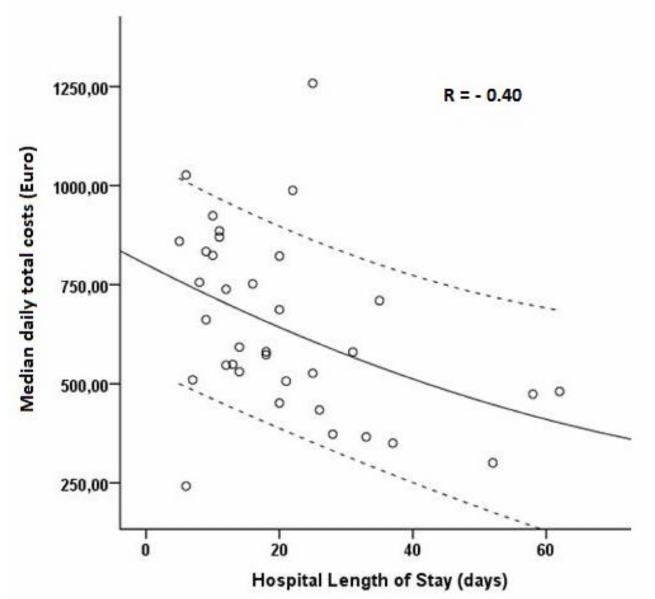
Figure 2. Correlation between total daily costs and hospital length of